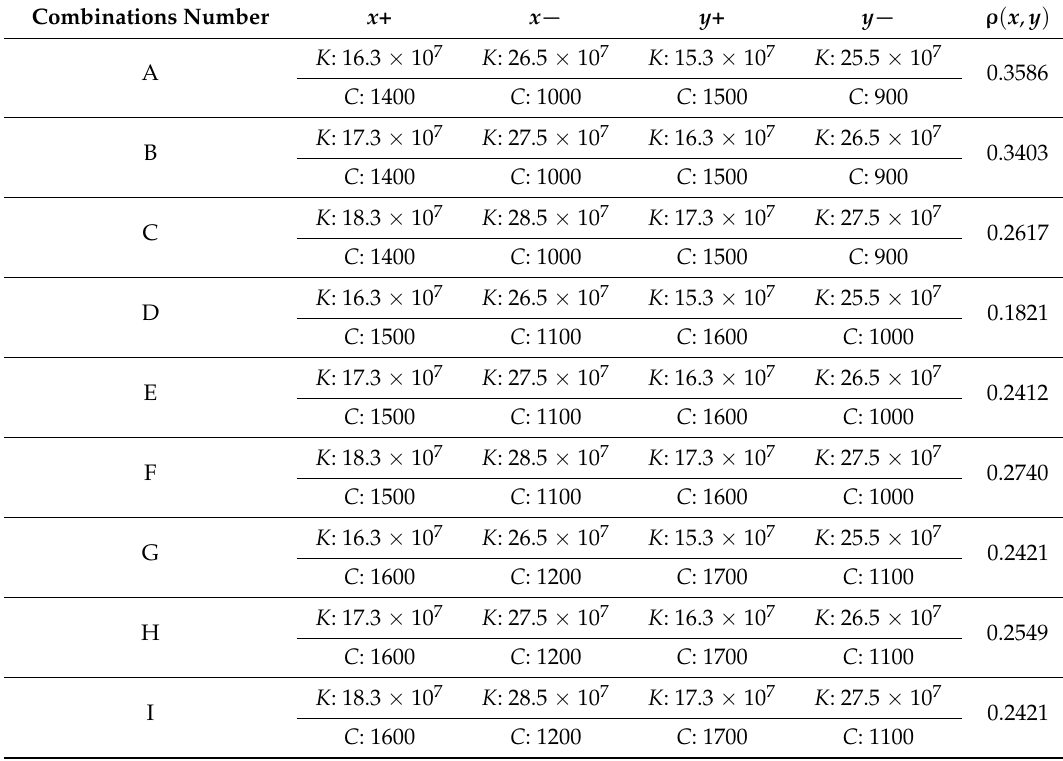
Table 4. The nine different combinations of stiffness and damping coefficients and the corresponding ρ ( x , y ) 1